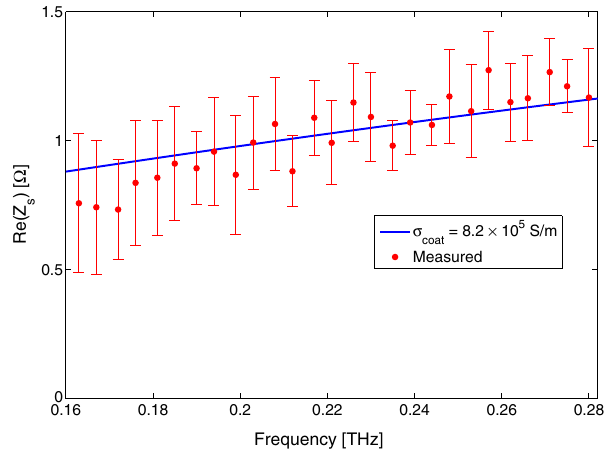
FIG. 17. Surface impedance estimation of the 3 . 68 μ m NEG coated slab: from averaged experimental data (red dots) and from best fit curve conductivity (blue).